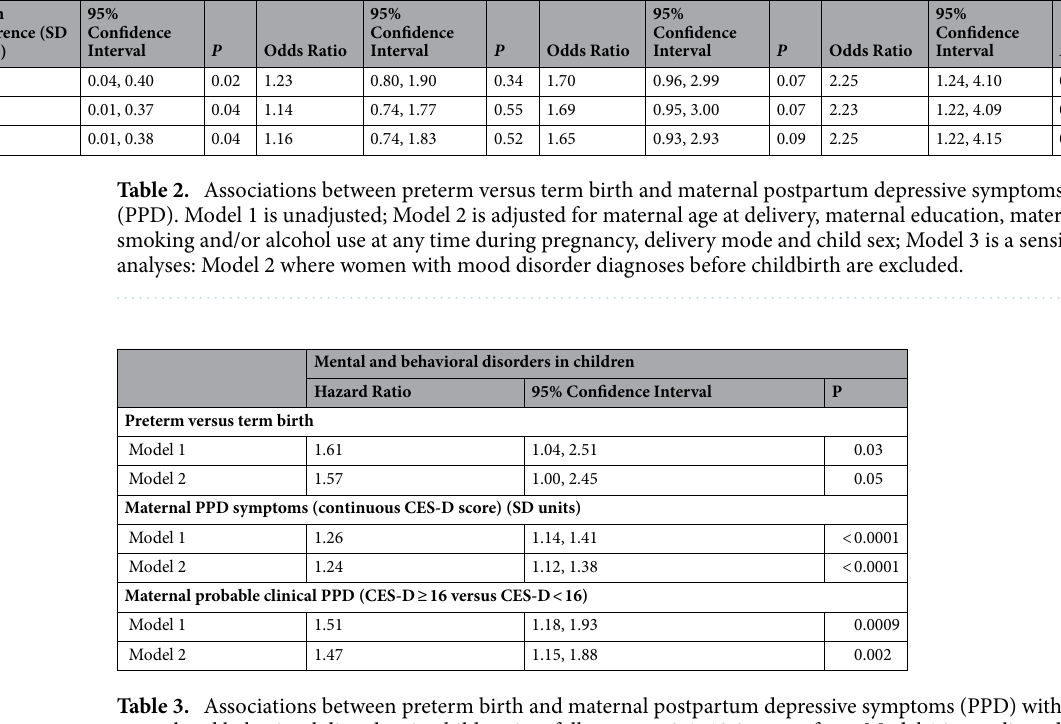
Table 3. Associations between preterm birth and maternal postpartum depressive symptoms (PPD) with mental and behavioral disorders in children in a follow-up to 8.4–12.8 years of age. Model 1 is unadjusted; Model 2 is adjusted for maternal age at delivery, education, smoking and/or alcohol use at any time during pregnancy, delivery mode and child sex. CES-D refers for Center for Epidemiologic Depression